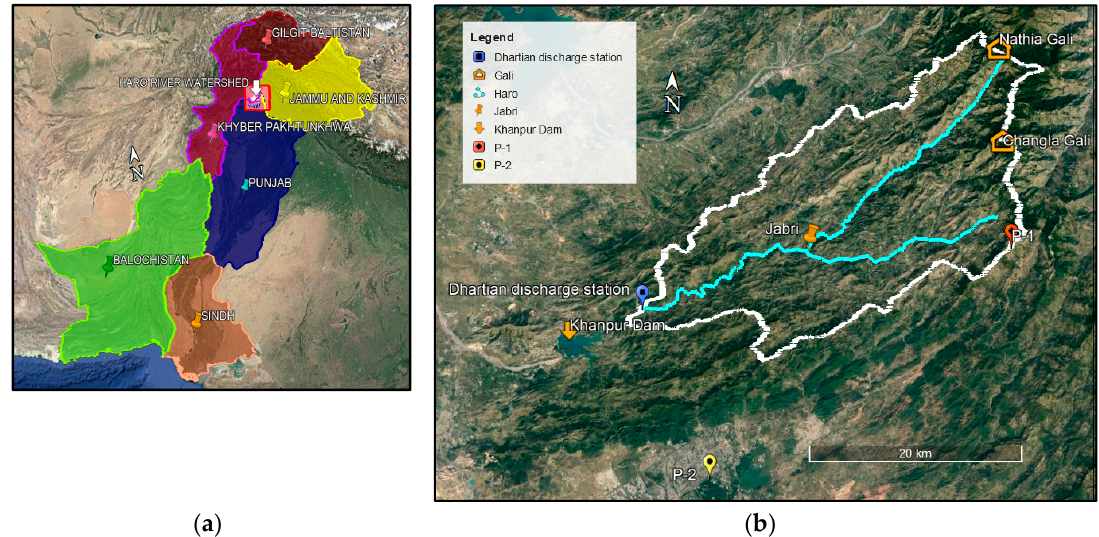
Figure 1. ( a ) Location of Haro River watershed in Pakistan; ( b ) main features of Haro River watershed.